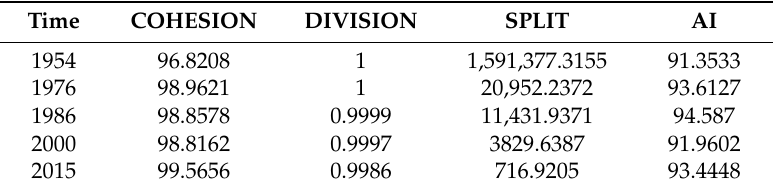
Table 2. Aggregation from 1954 to 2015.